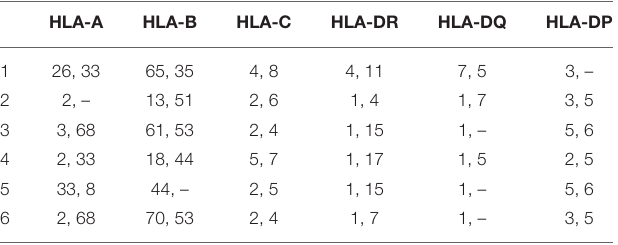
HLAprofilesforthesixrandombonemarrowdonorsusedintheComplement-Dependent Cytotoxicitycrossmatchtest.ThenumbersrepresentHLAphenotypesforeachsubclass. Dash symbol indicates homozygous